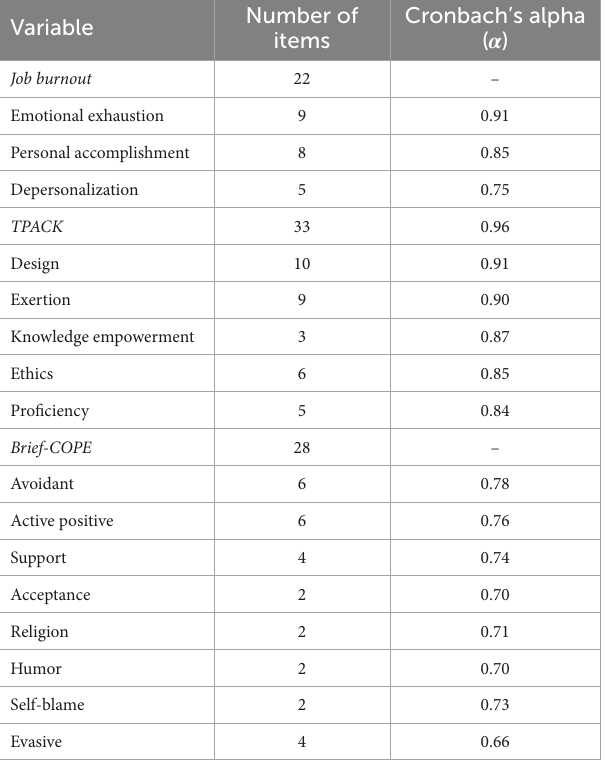
TABLE 1 Reliability indices of the